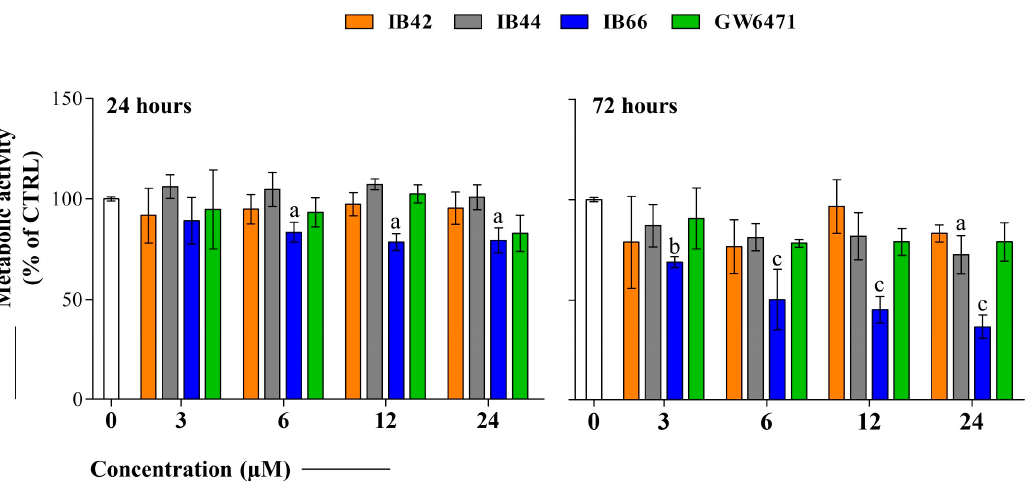
Figure 2. Cell metabolic activity of MCF7 cells in the presence of phenylsulfonimide derivatives. Bar graphs represent the cell percentage of metabolically active cells in the presence of increasing concen- trations (0–3–6–12–24 µ M) of IB42, IB44, IB66, and GW6471 after 24 and 72 h of exposure. Optical density readings in untreated cultures (0 μ M) were set to 100%. Bars show mean values ± standard deviations summarized from individual values in independent experiments (n = 6). Lower case letters indicate significant differences between untreated cell cultures (0 µ M) and treated samples: a ( p < 0.01), b ( p < 0.001), and c ( p < 0.0001). CTRL = 0 µ